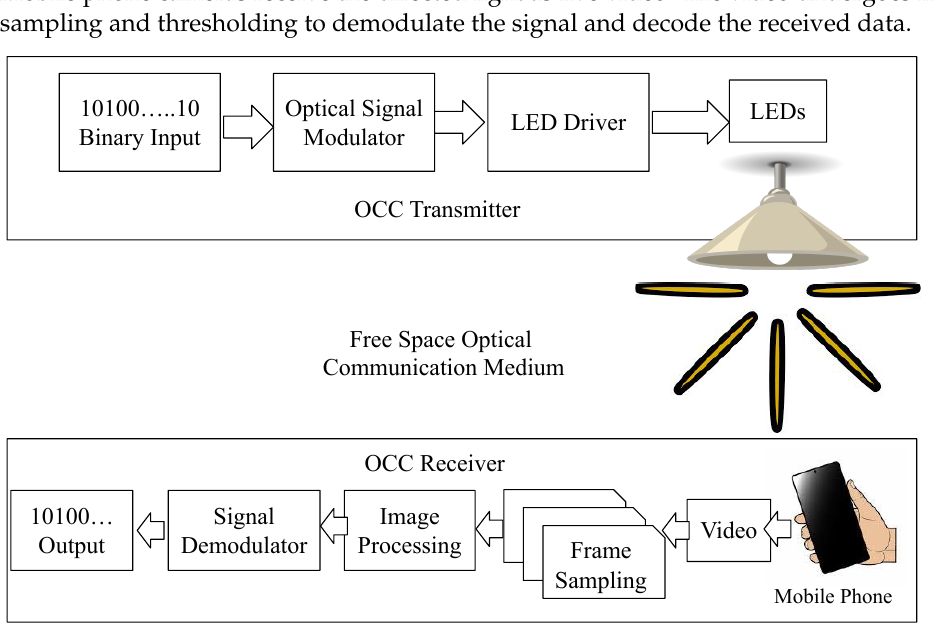
Figure 2. The schematic block diagram of an OCC